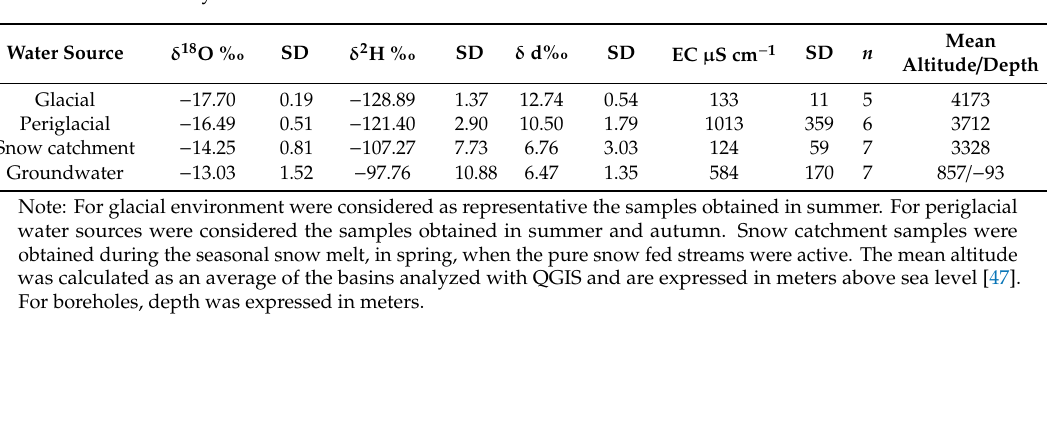
Table 3. Stable isotopes and electric conductivity mean and standard deviation values for the di ff erent water sources analyzed.